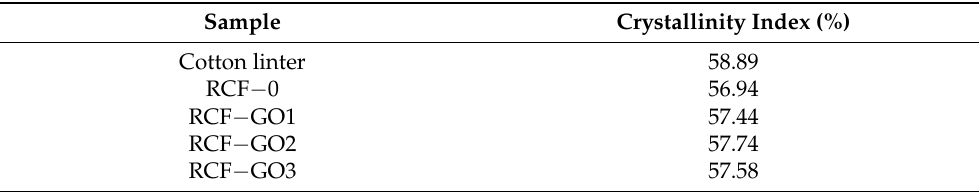
Table 1. The crystallinity index of RCFs with and without GO.